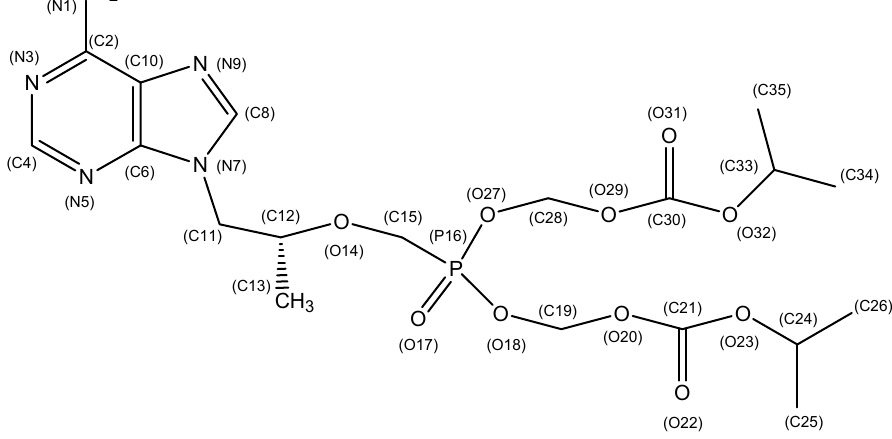
Figure 1. Molecular diagram of the Tenofovir disoproxil (TD) free base with the atomic numbering scheme.